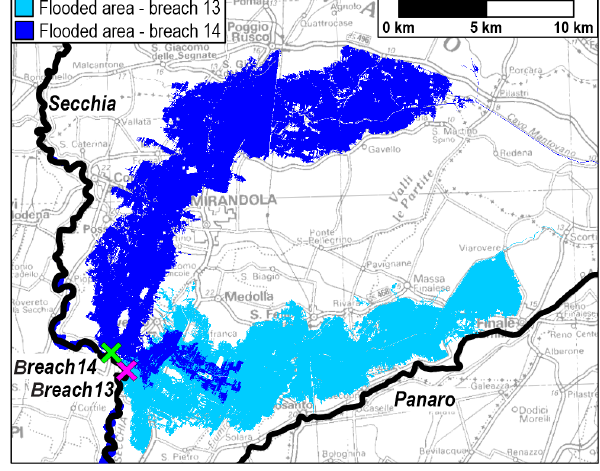
Figure 6. Example of the simulated flooded areas generated by two consecutive breaches (nos. 13 and 14) on the Secchia River (the breach positions are indicated by crosses) for inflow B: the first breach scenario (cyan) mainly involves the eastern part of the domain, whereas the inundation for the second one (blue) moves northwards. The topographic map in background is made available by Emilia-Romagna region at https://geoportale.regione. emilia-romagna.it/it (last access: 8 January